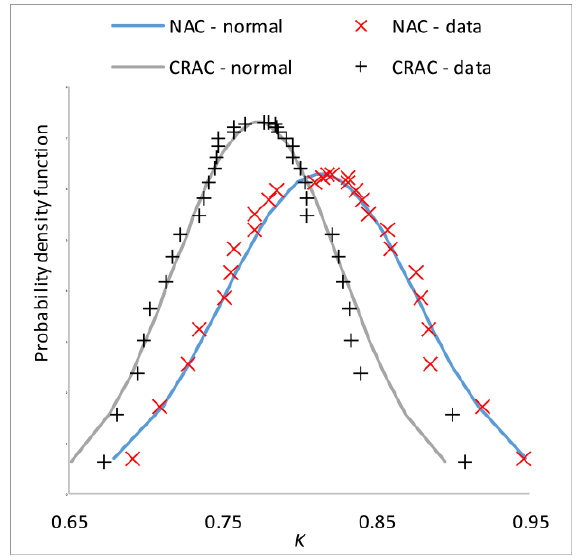
Figure 3. Probability goodness-of-fit.